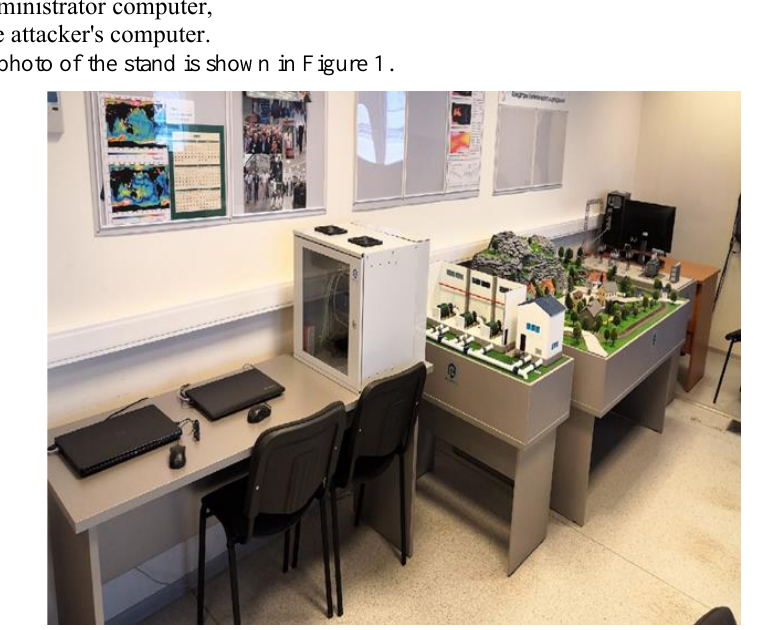
Fig. 1 . General photo of the studied